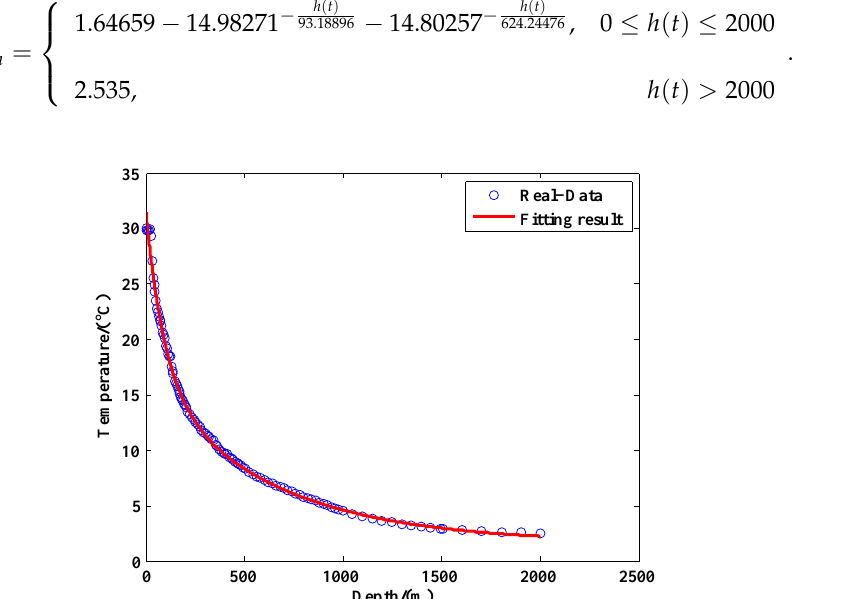
Figure 8. The fitting effect of the temperature at depth 0 m to 2000